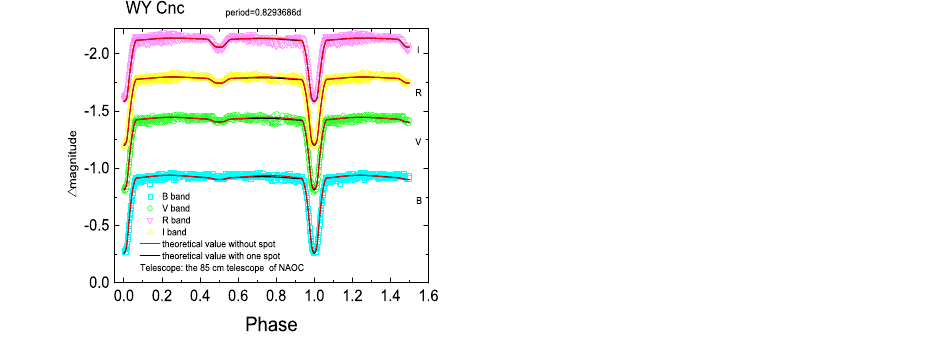
Figure 4. The theoretical and observational light curves of WY Cnc, where the spot is on the primary component.